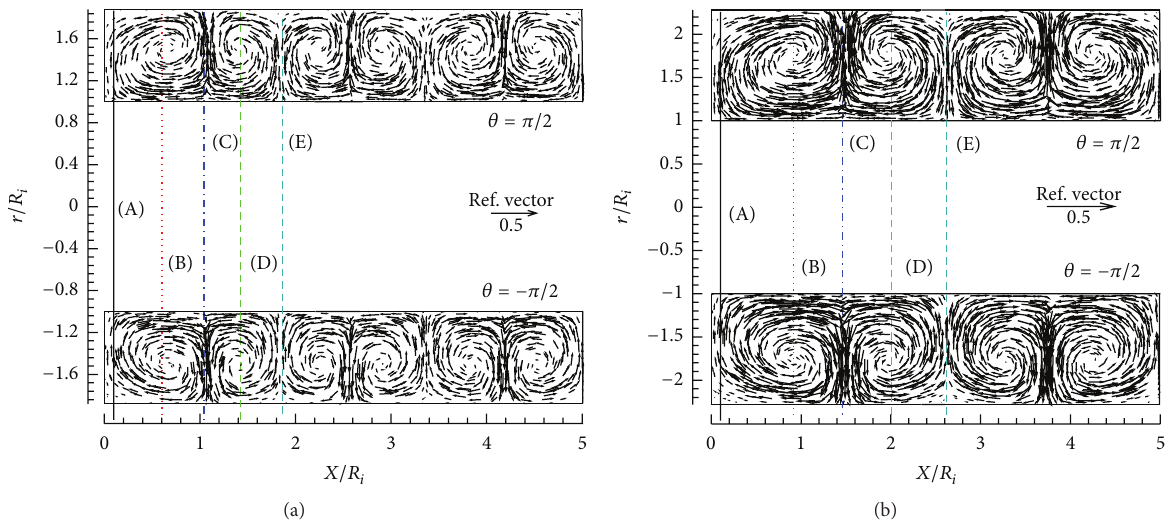
Figure 4: Normalised velocity vectors in the meridional plane of the annulus for test cases (a) Γ = 11.36 and (b) Γ = 7.81 . The reference velocity vector magnitude is 0.5 Ω𝑅 𝑖